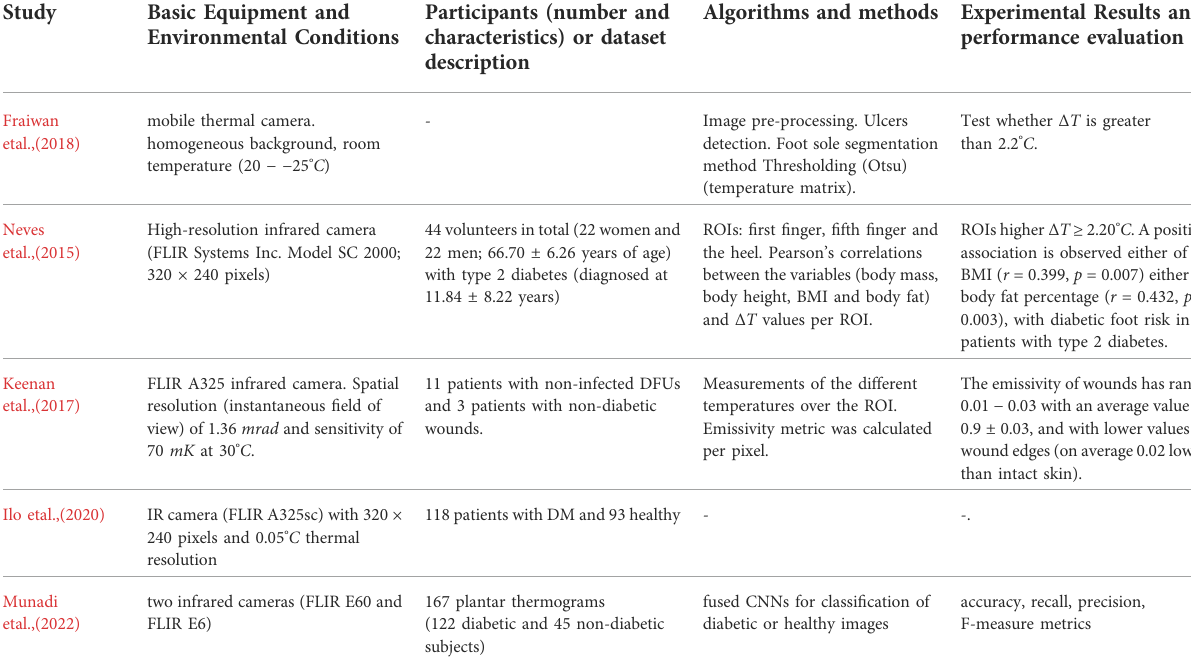
TABLE 6 ( Continued ) Summary of the literature for diabetic foot monitoring using imagery data from thermal